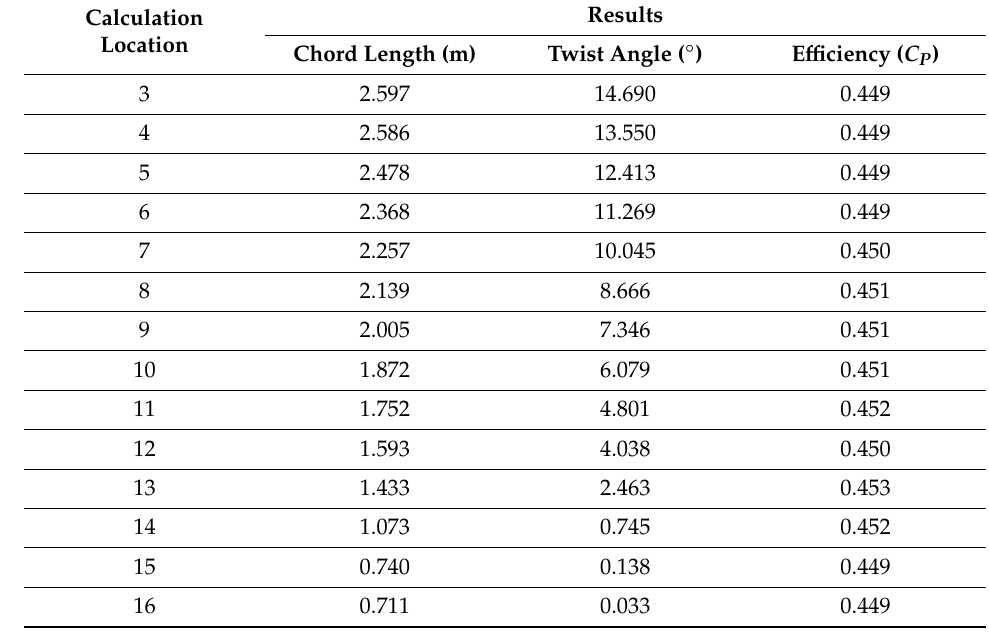
Table 5. Optimized results for each calculation location.